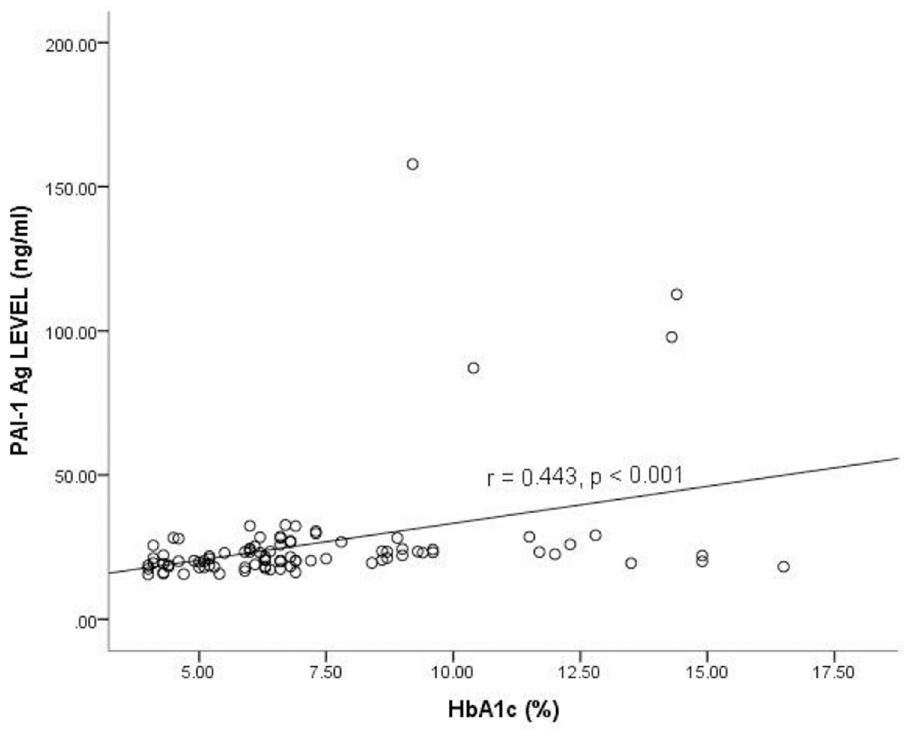
Fig 1. Correlation between Plasminogen Activator Inhibitor-1 antigen level and glycated hemoglobin among the study participants levels. HbA1c = Glycated hemoglobin, PAI-1 Ag = Plasminogen activator inhibitor 1 antigen, r = Correlation coefficient. Spearman correlation was used to determine the correlation between the plasma PAI-1 antigen and HbA1c. p < 0.05 was considered statistically significant.